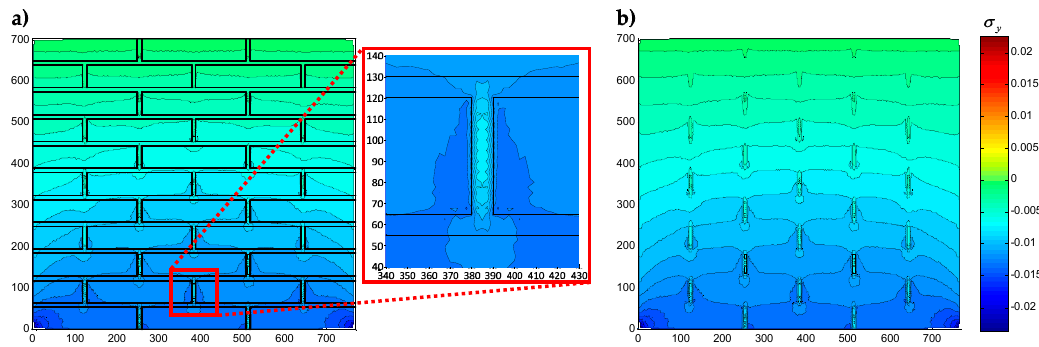
Figure 1. Isolines of the normal stress σ y (the y -axis runs vertically): ( a ) With and ( b ) without the arrangement of the bricks in the foreground (stress values in N/mm 2 and linear measurements in mm).